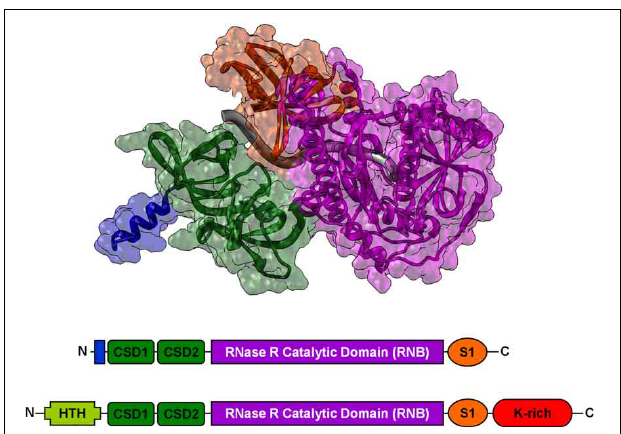
FIGURE 7 | Comparison of 2D and 3D structures of Rnase II and Rnase R. Top: Cartoon and surface representation of the crystal structure of RNase II D209N mutant bound to an RNA fragment (Frazao et al., 2006) (PDB entry 2IX1). The N-terminal domain is blue, cold-shock domains are green, the catalytic domain is magenta, the S1 domain is orange, and the RNA fragment is gray. Bottom : Schematic representation of the RNase R and RNase II domain architectures. RNase R and RNase II are very similar, with two cold-shock domains, a large central catalytic domain, and the S1 domain. However RNase R has two additional domains: an N-terminal putative helix–turn–helix (HTH) domain, and a C-terminal lysine-rich (K-rich) domain crucial for its non-stop mRNA degradation